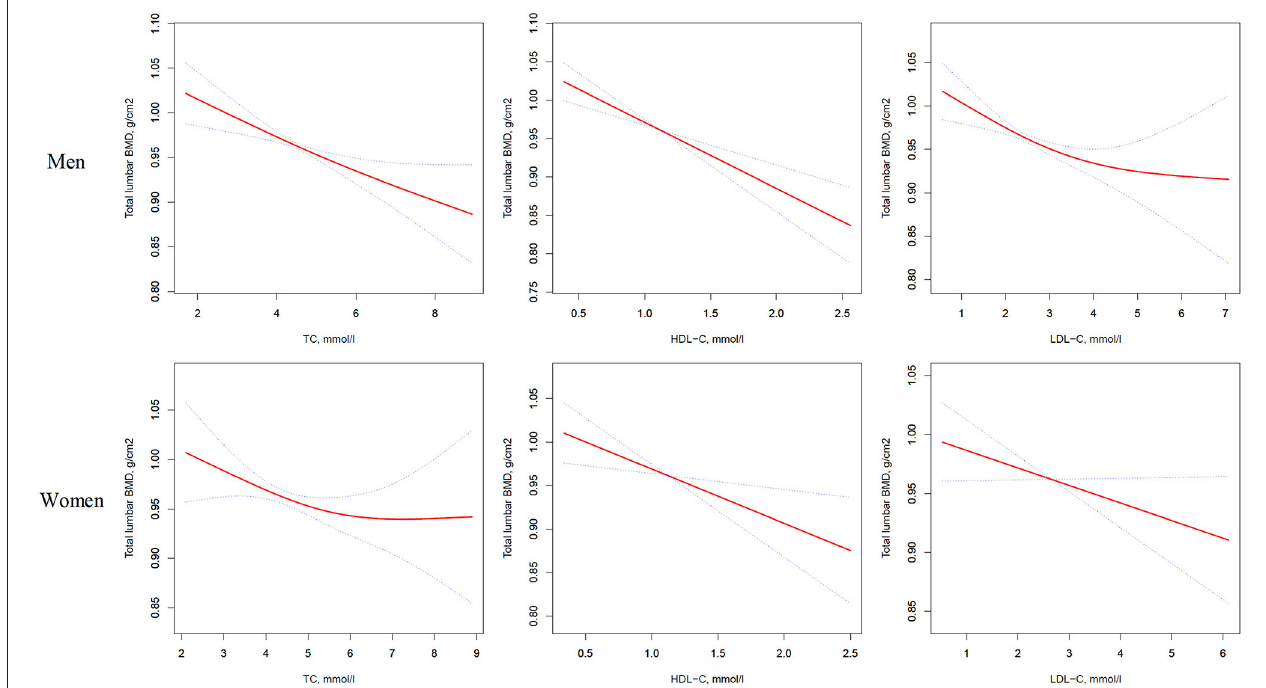
FIGURE 1 | Multivariate adjusted smoothing spline plots of total lumbar BMD by TC, HDL-C, and LDL-C. Red dotted lines represent the spline plots of TC, HDL-C, and LDL-C and blue dotted lines represent the 95% CIs of the spline plots. Adjusted for age; diabetic duration(y); treatment of DM; smoking; drinking; BMI; cerebrovascular disease; kidney disease; family history of DM; diastolic blood pressure; FBG, unit; Cr, umol/l; BUN, mmol/l; Ca, unit; ALT, U/L; AST, U/L; ALP, U/L.